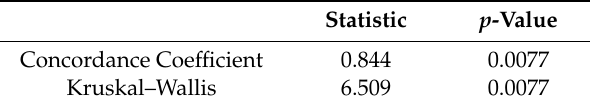
Table 12. Kruskal–Wallis and concordance test for Aa.